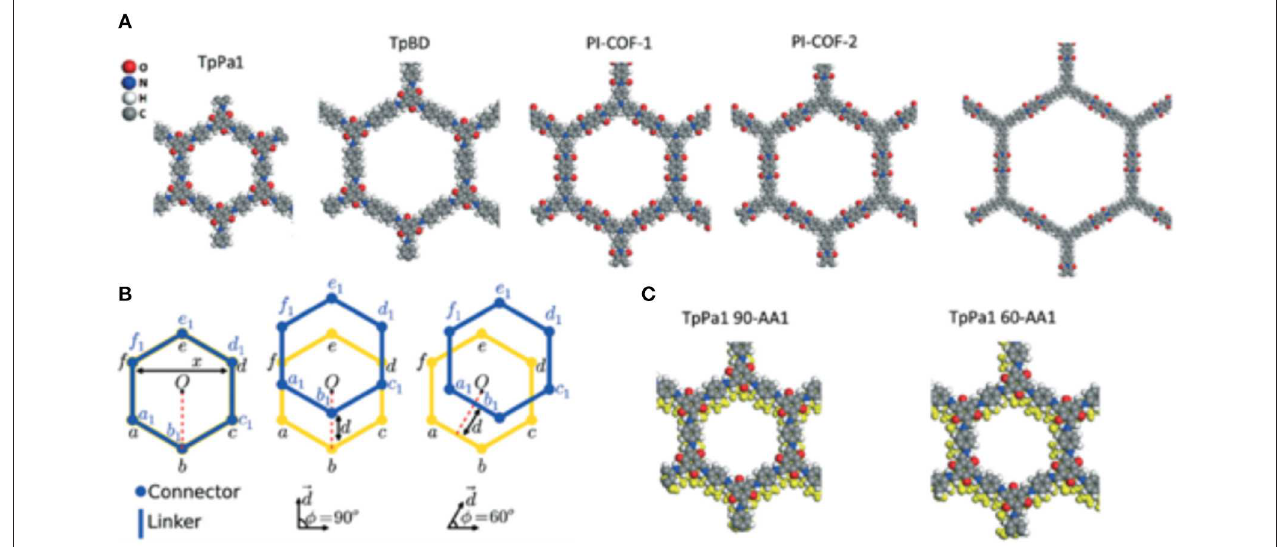
FIGURE 13 | The eclipsed (A) stacked structures of the COFs, (B) illustration of the stacked and slipped structures along 90 and 60 ◦ directions a-f (yellow) represents the bottom layers and a 1 -f 1 (blue) represents the top layers and (C) illustration of the TpPa1 COF with 90 ◦ slipping and 60 ◦ slipping by 1.7 Å in both cases. Reprinted with permission © The Royal Society of